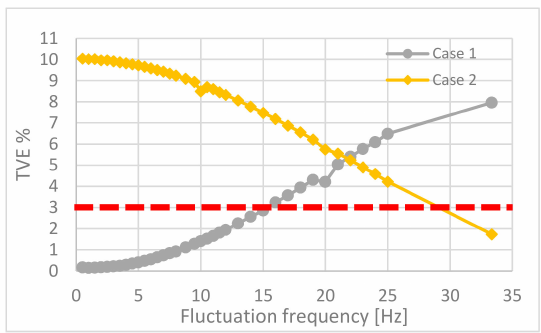
Figure 9. TVE results for PMU C with P configuration and F s = 100 fps.